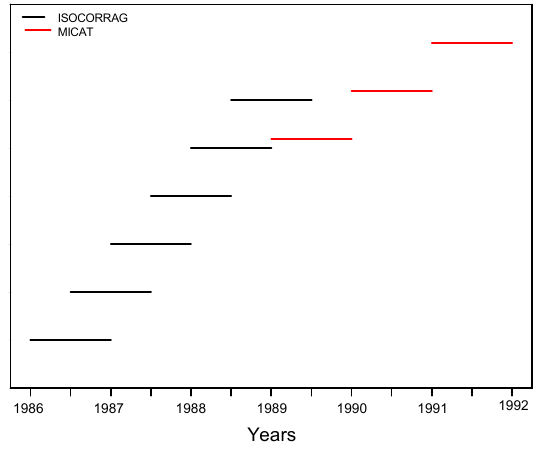
Figure 4. ISOCORRAG and MICAT programmes: diagrams showing the exposure sequences. Table 2. Atmospheric corrosion test sites included in the ISOCORRAG Programme.